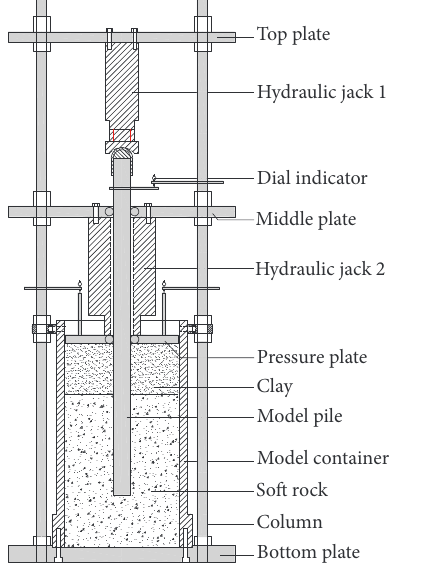
Figure 9: Schematic illustration of the model test apparatus.